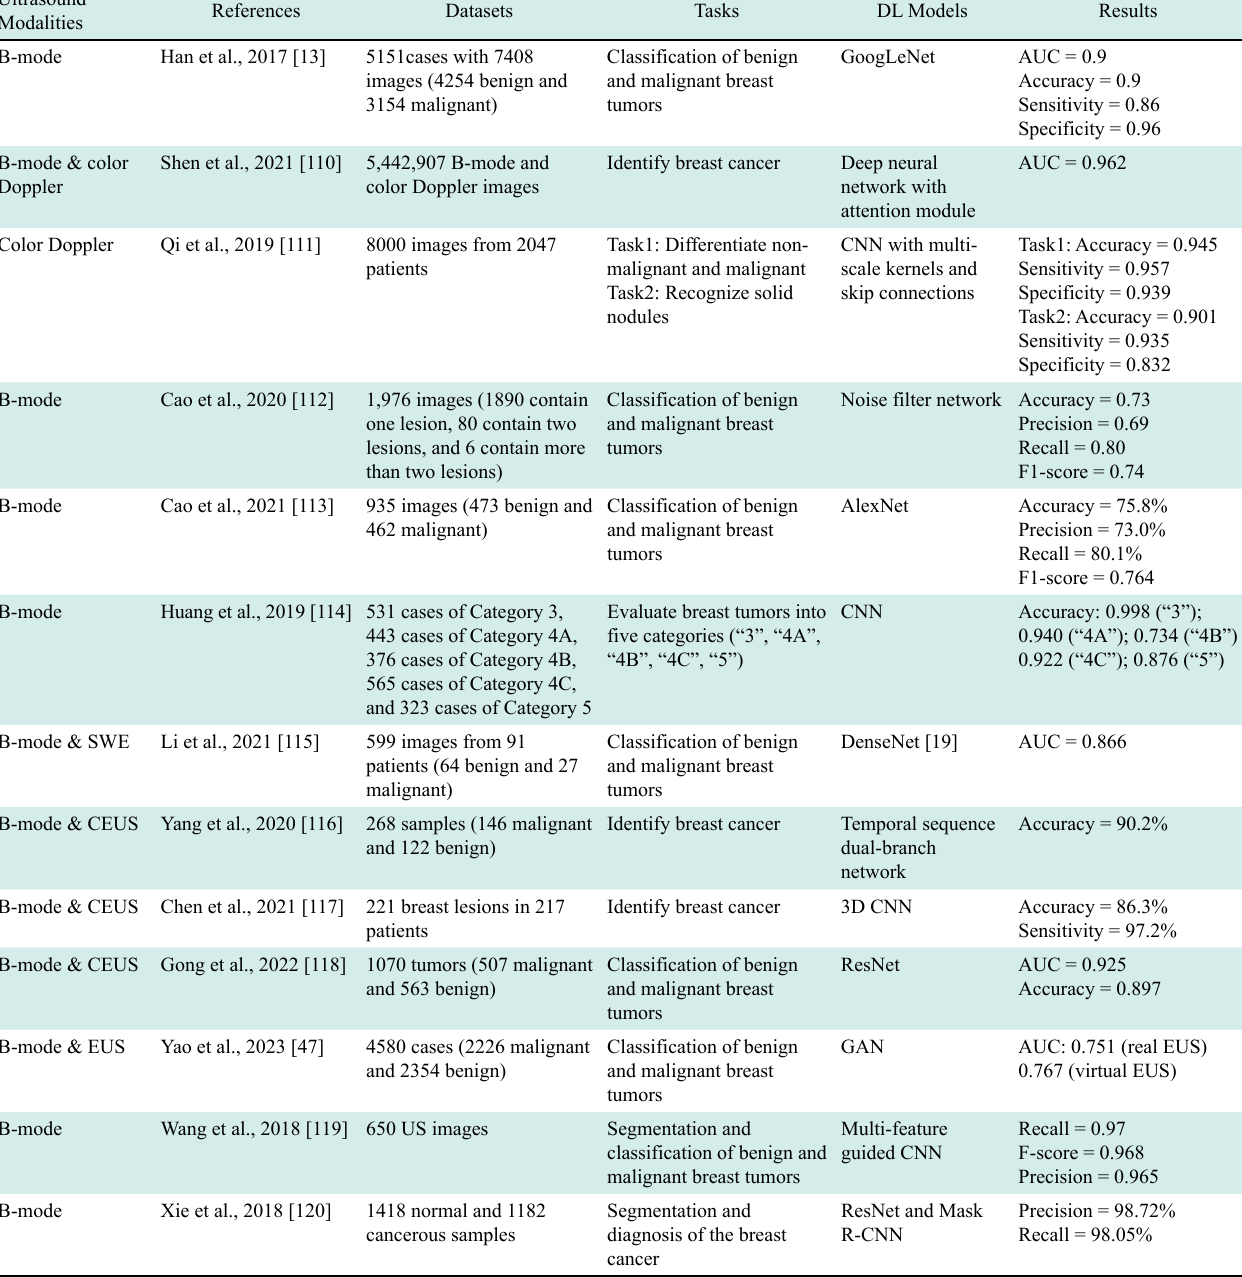
Table 3 Deep learning for breast cancer diagnosis in